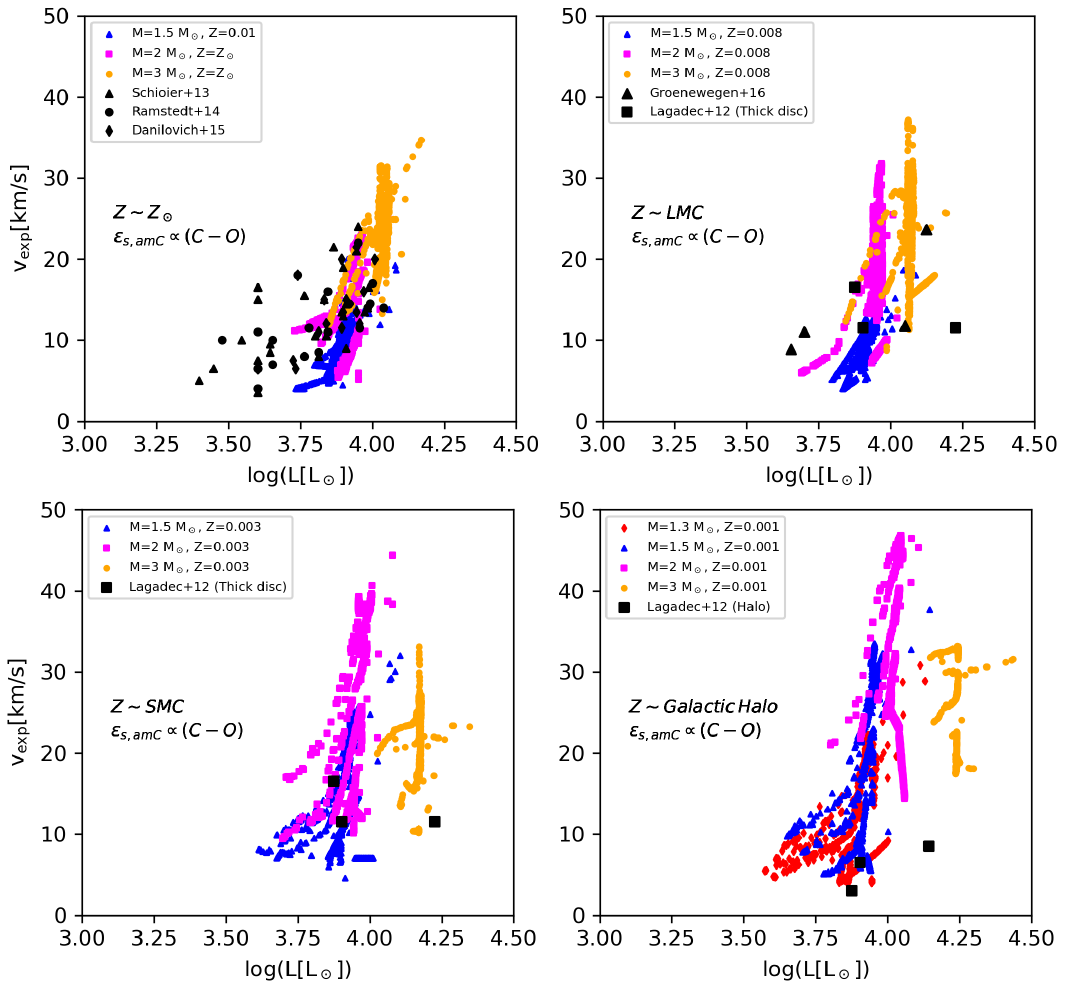
Figure 3. Comparison between observed and predicted expansion velocity vs. luminosity for different metallicity values mentioned in the panel for the selected tracks in the legend (coloured symbols). Black points represent the quantities derived from the observations of C-stars, as mentioned in the legend. The seed particle abundance for amC dust is assumed to be proportional to the carbon excess (see Table